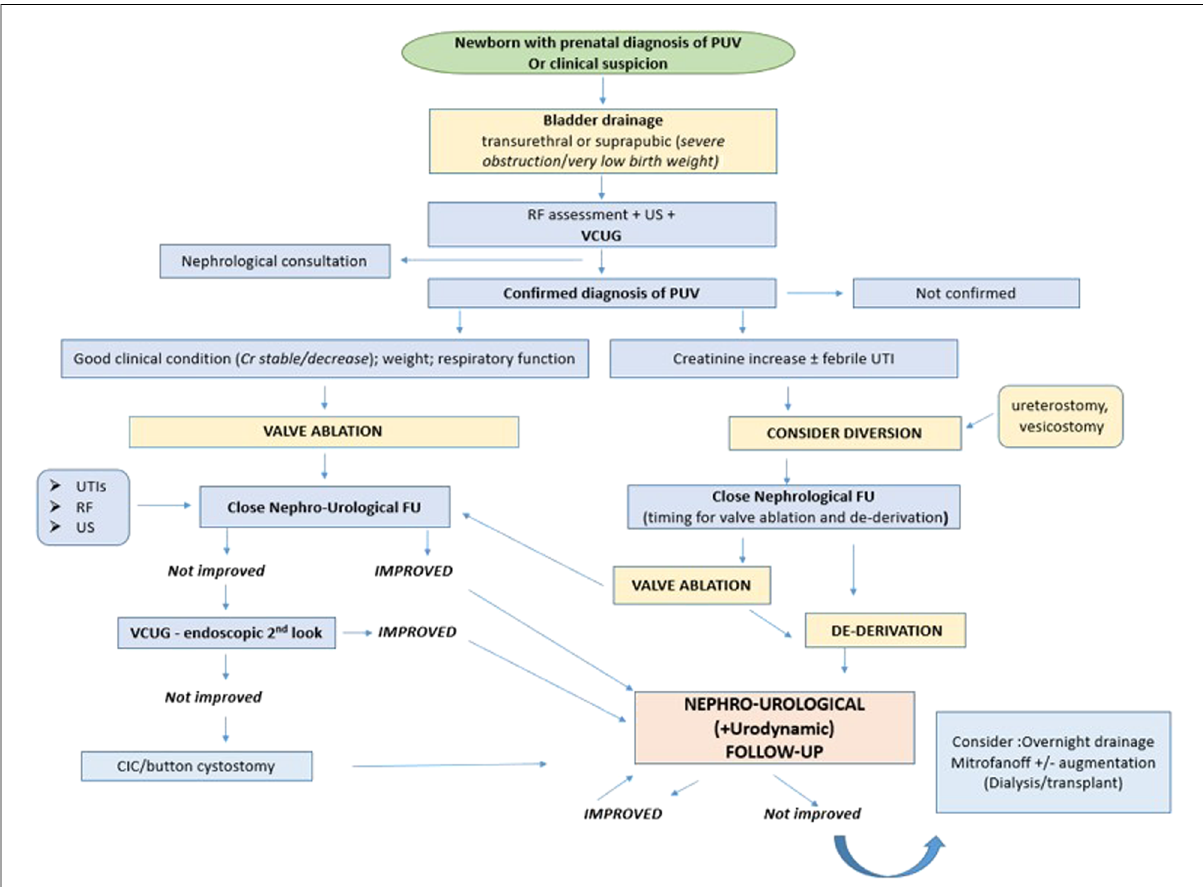
FIGURE 1 Post-natal management of PUV. PUV, posterior urethral valves; RF, renal function; US, ultrasound; VCUG, voiding cystourethrogram; UTI, urinary tract infection; FU, follow-up; Cr,